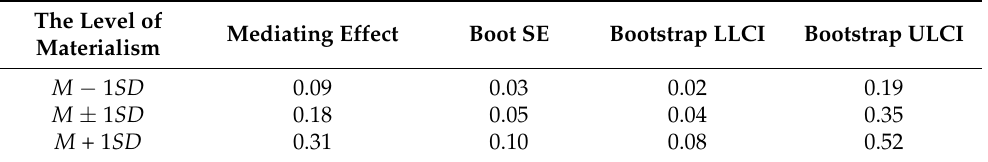
Table 3. The conditional indirect effect